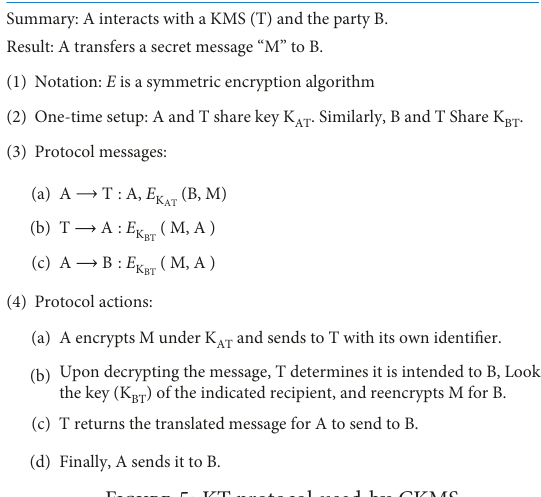
Figure 5: KT protocol used by